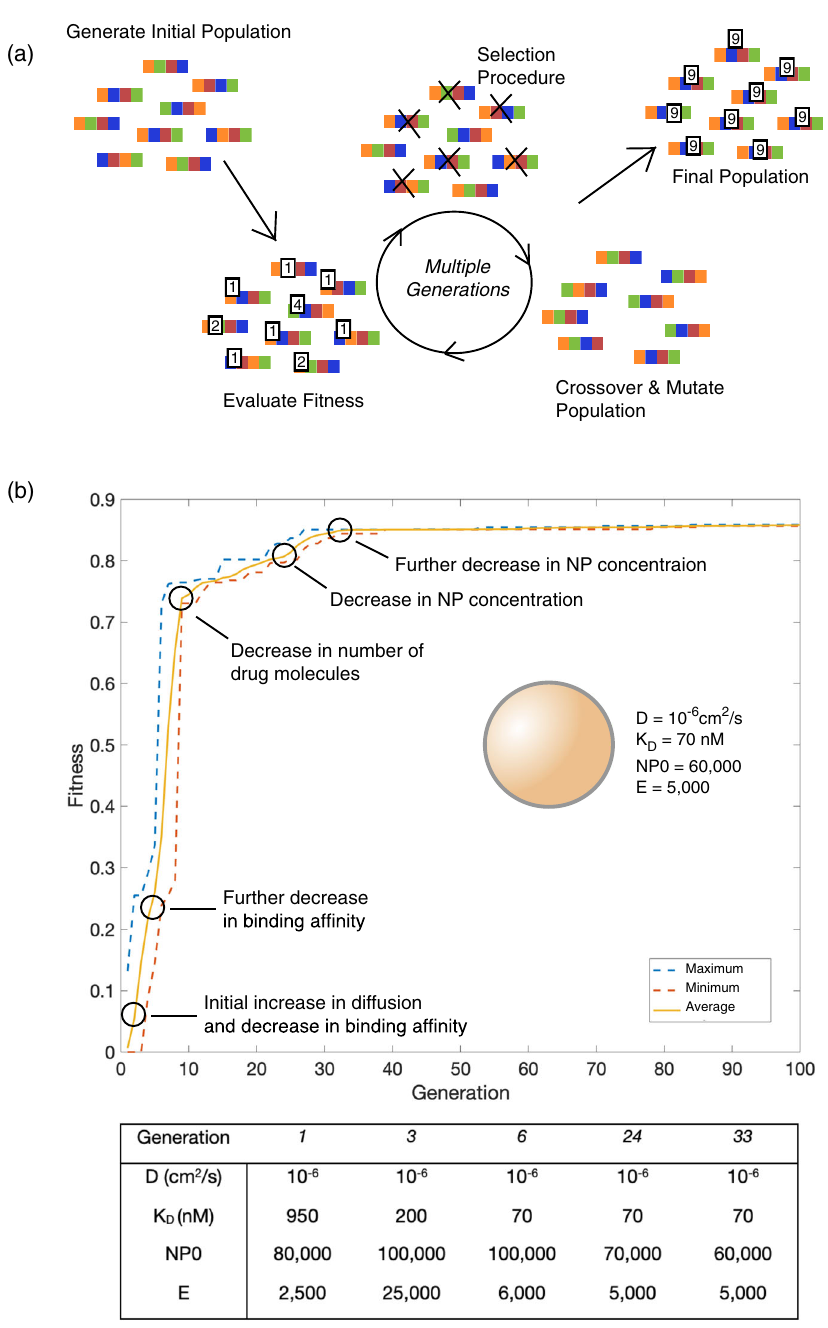
Fig. 4 Machine learning module of the EVONANO platform. We use ( a ) an evolutionary algorithm to optimise nanoparticle design. This optimisation routine fi rst initialises a population of different parameter sets and evaluates the fi tness of each parameter set using the tissue module. Parameter sets with high fi tness are selected for (using a tournament procedure) and these sets are used to generate a new population of nanoparticle parameters using the crossover operator (where the information of the two parent solutions are combined to make new solutions), and the mutation operator. This process is repeated for a prescribed number of generations, resulting in an overall increase in the fi tness of the parameters and effective nanoparticle treatments. We show in ( b ) the mean, maximum and minimum change in fi tness across generations and highlight the changes of importance in parameters as we optimise the nanoparticle treatment, where parameter changes are shown in the